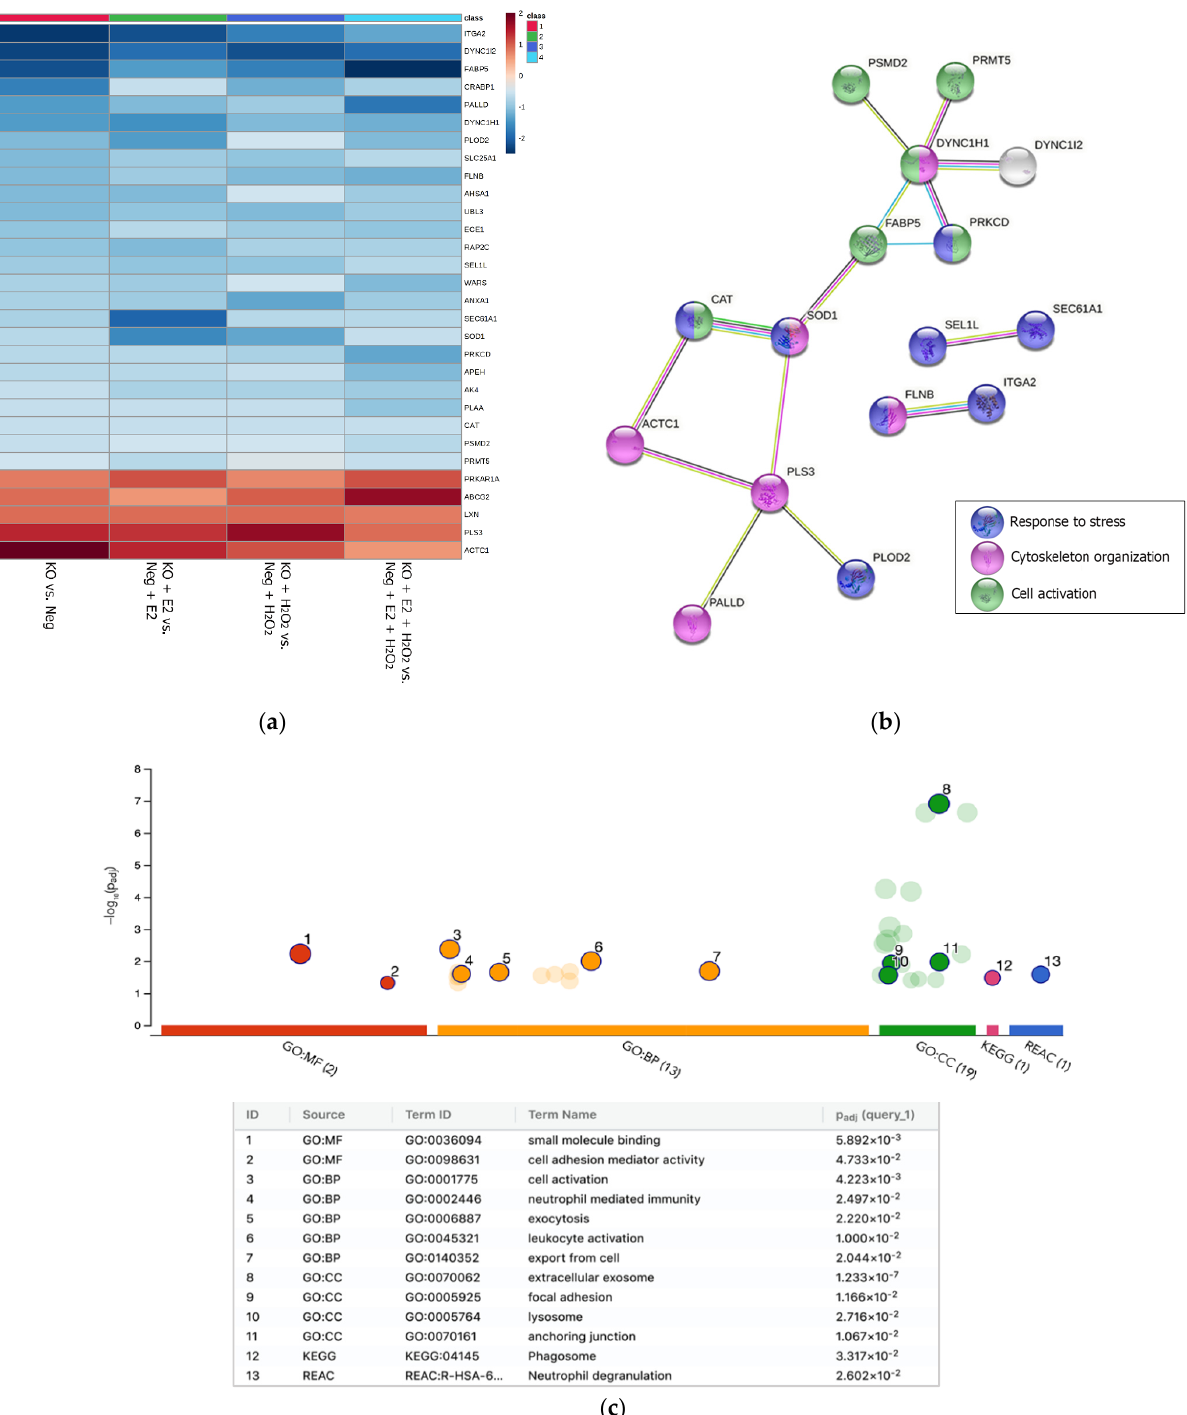
The red-marked protein refers to the single protein of the common dataset with discordant quantitative behavior through- out the experimental conditions.